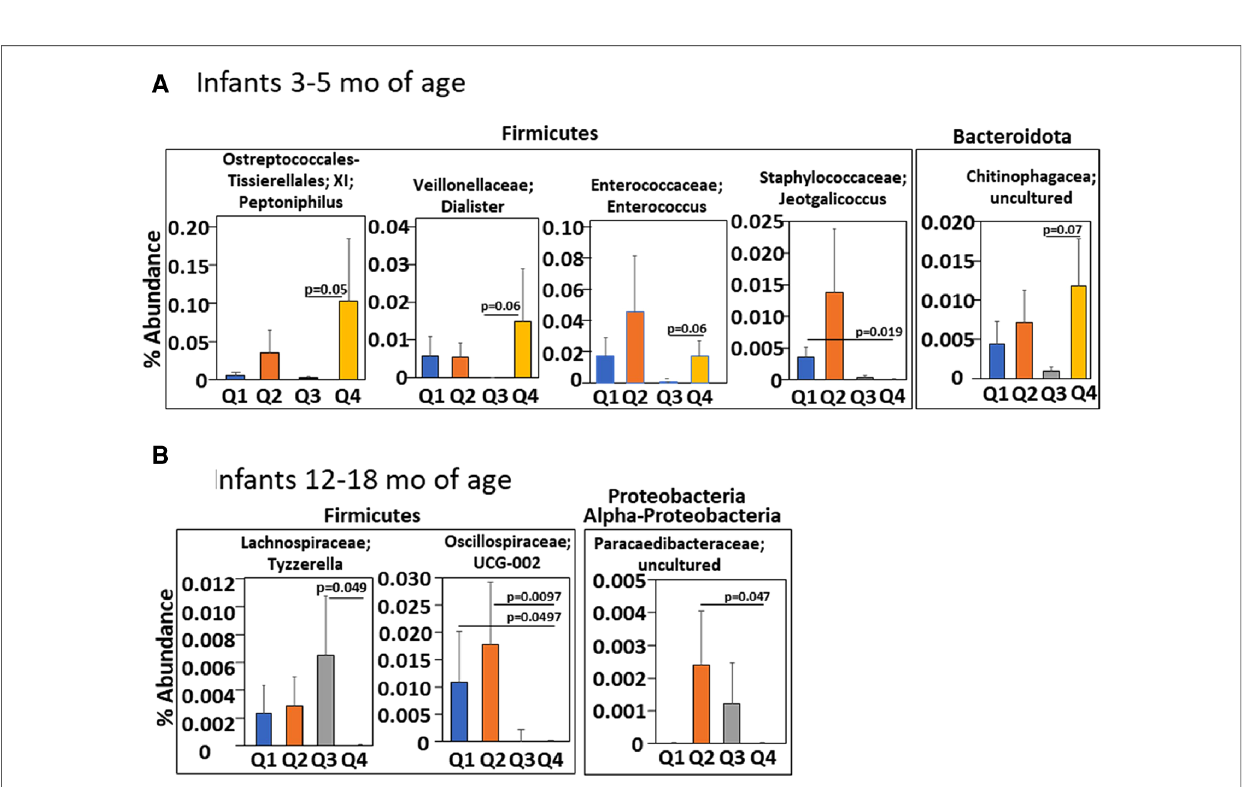
FIGURE 8 Infants with an anti-in fl ammatory tocopherol isoform pro fi le (higher α T, lower γ T) for allergic responses had a different abundance of bacterial microbiota compared to other tocopherol isoform pro fi les. Serum α T and γ T for infants in the INHANCE cohort were measured by HPLC. Four groups of infants (Q1, Q2, Q3, Q4) for 3 – 5 months and for 12 – 18 months infants were generated using high and low α T and γ T concentrations in ( Table 1 ) that were de fi ned as higher or lower than the median concentration for the tocopherol isoform for the age group. ( A ) 3 – 5 months and ( B ) 12 – 18 months of life. p values are given for signi fi cant differences or trends in taxa compared to group